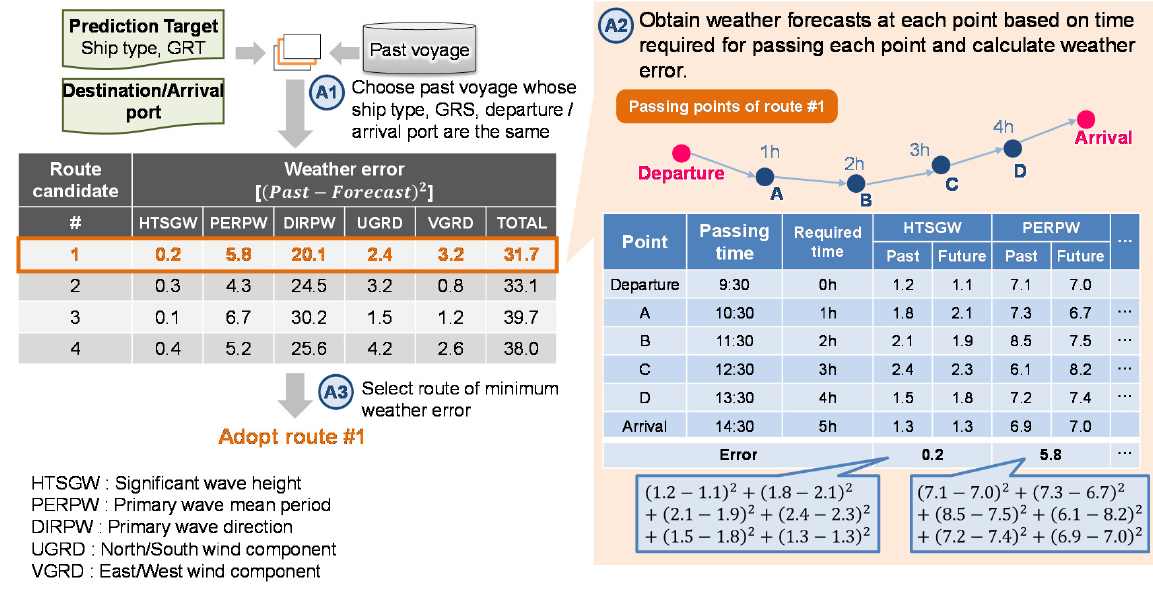
Figure 4. Overview of vessel routing procedure.